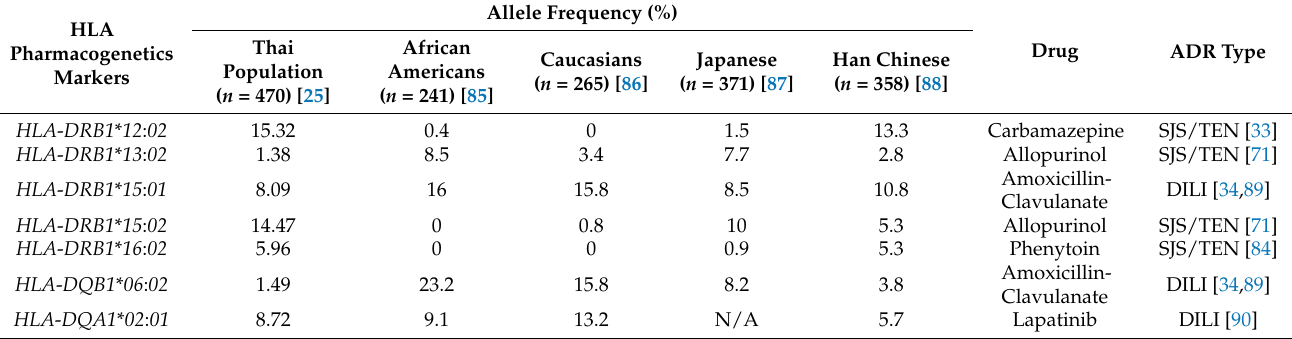
Table 4. The frequencies of class II HLA -associated drug hypersensitivity and related drug adverse reactions. HLA